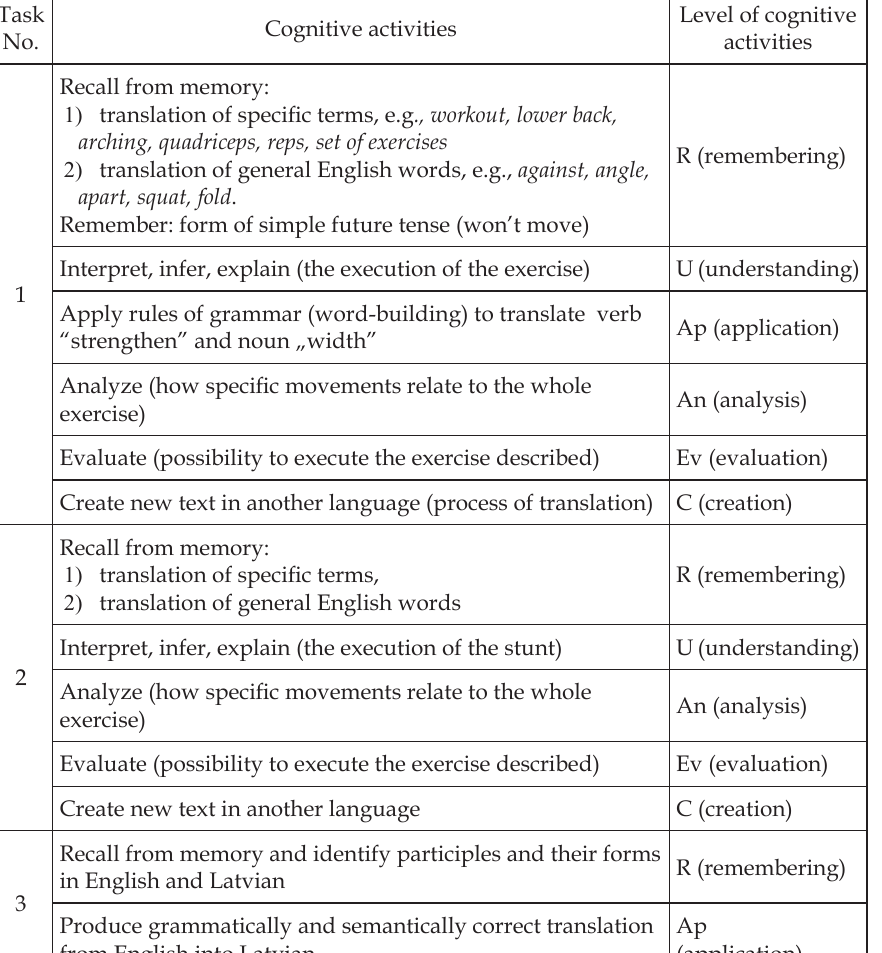
Table 1. Cognitive activities used in doing Task 1 and Task 3 Task